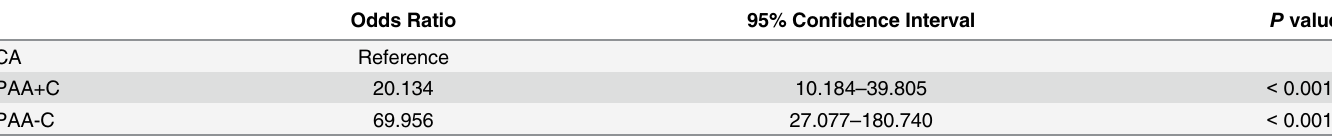
Table 4. The risk of causing more amount of intraoperative hemorrhage in PAA+C and PAA-C groups compared to the CA